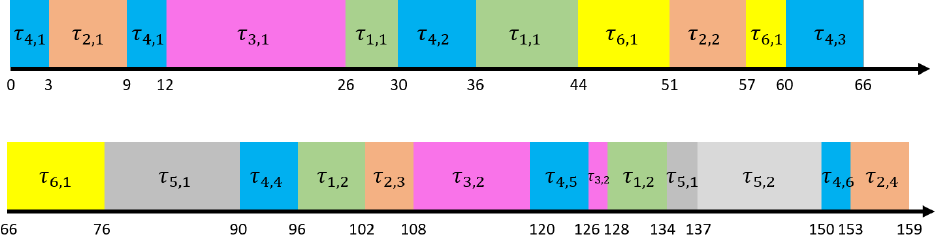
Figure 2. Scheduling results of task sets under the improved FMC